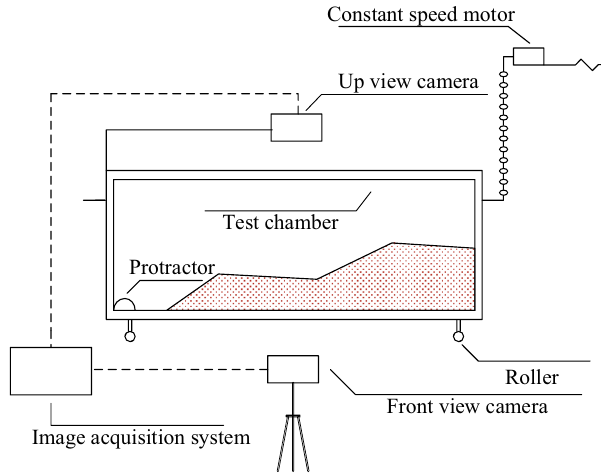
Figure 2. Test device diagram.